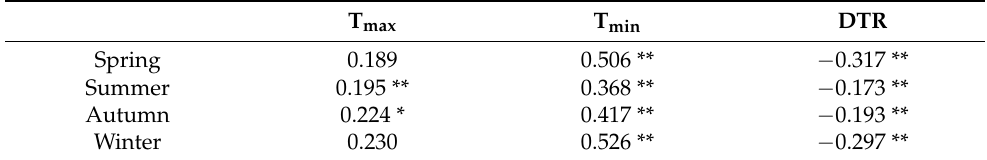
Table 2. Seasonal trends ( ◦ C/Decade) of T max , T min , and DTR in northeast China from 1961 to 2015. T max T min DTR Spring 0.189 0.506 ** − 0.317 ** Summer 0.195 ** 0.368 ** − 0.173 ** Autumn 0.224 * 0.417 ** − 0.193 ** Winter 0.230 0.526 **